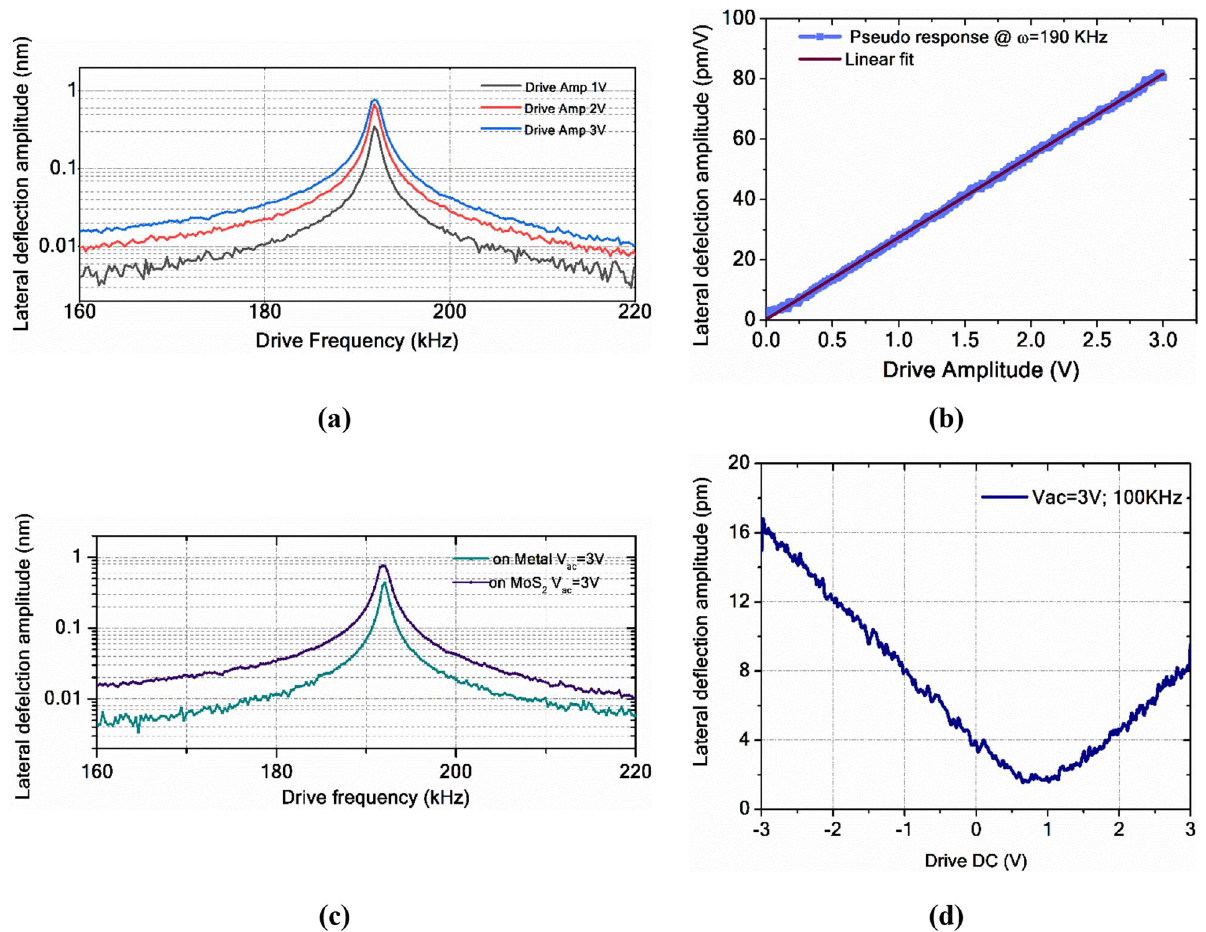
Figure 4. ( a ) Frequency response curves of lateral piezoresponse at different drive amplitudes showing the tuning of contact resonance with applied drive amplitude ( V ac ). ( b ) Pseudo-piezoelectric response on the metal electrode near contact resonance. ( c ) Lateral frequency response curves on the metal (source electrode) and suspended MoS 2 near contact resonance at Vac = 3 V. ( d ) Lateral piezoelectric response on MoS 2 at different DC